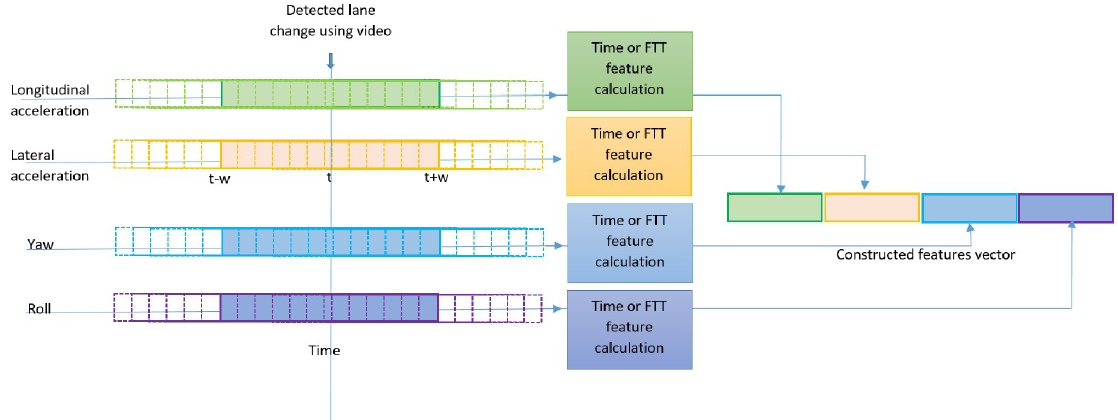
Fig 3. Illustration of constructing a lane change training example using the time of the event and the raw accelerometer data.